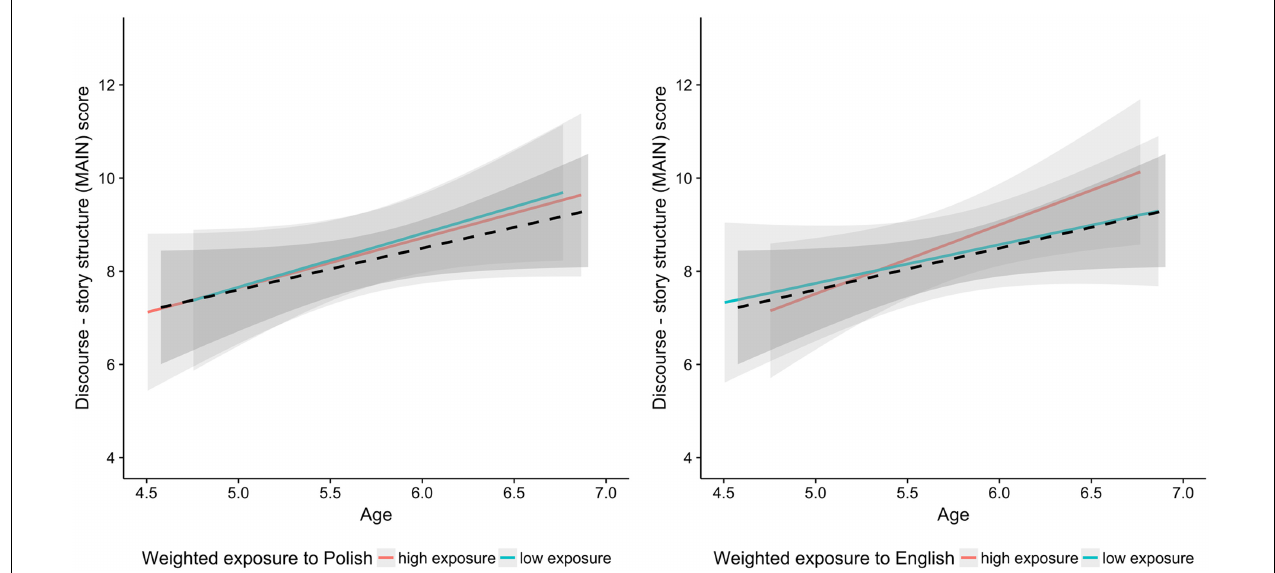
FIGURE 8 | Scores on the story structure plotted as a function of age. Black dashed line indicates the monolingual group and the two colored lines correspond to the bilingual group. The data for bilinguals is broken down by the median split amount of weighted exposure to Polish and English. Red and aqua correspond to the median split on exposure to L1 Polish (left side) and to L2 English (right side). The median split was performed for visualization purpose